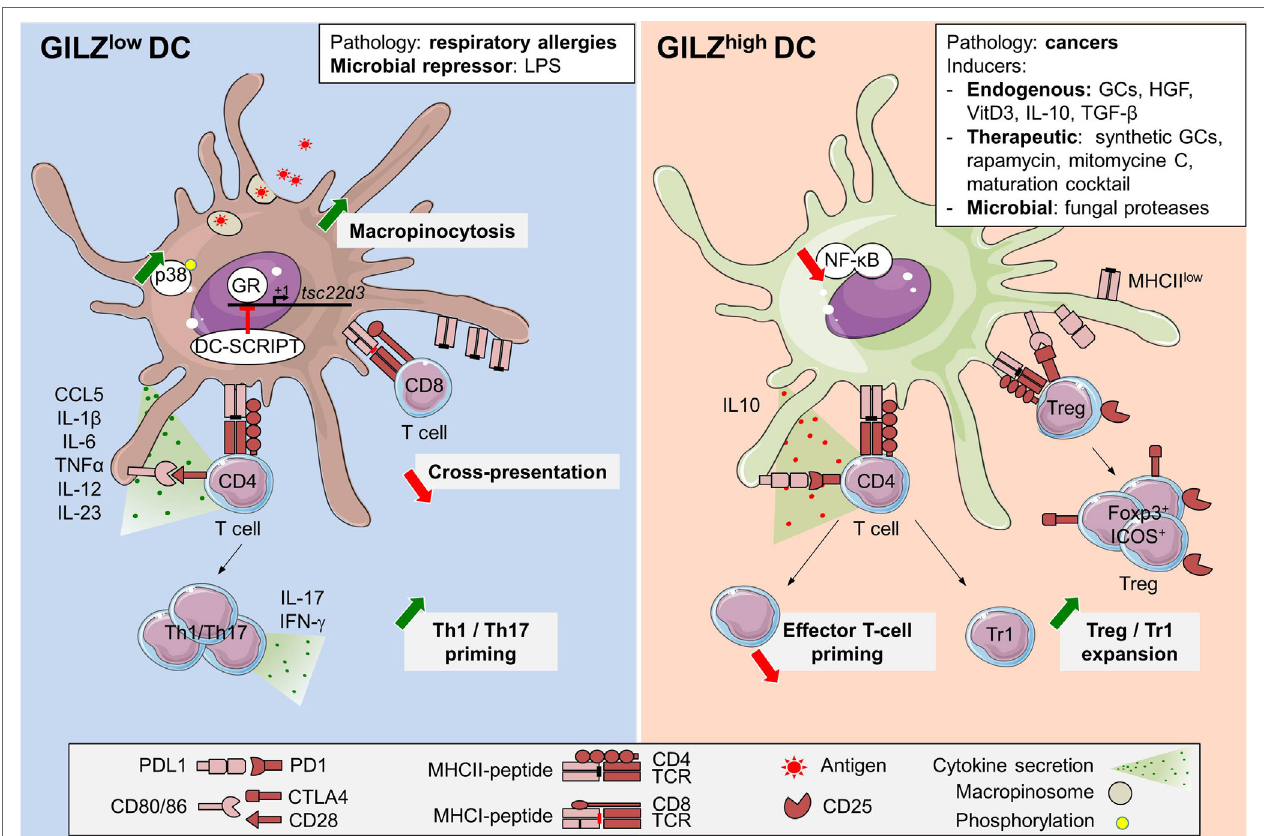
FiGURe 2 | Glucocorticoid-induced leucine zipper (GILZ) regulation and functions in dendritic cells (DCs). GILZ expression in DCs can be induced by steady-state factors (11, 21, 22), immunosuppressive cytokines like TGF- β or interleukin (IL)-10 (20, 25), DC-maturation cocktail containing TNF- α , IL-1 β , IL-6, and PGE2 (24), cell-derived factors (26, 45, 67), immunosuppressive drugs as synthetic GCs, rapamycin, and mitomycine C (11), fungal proteases (68), and cancer microenvironment (26). So far, the only exogenous GILZ repressor reported in DCs is LPS (26, 27). In addition, GILZ levels are reduced in blood DCs from respiratory allergic patients (21). DC-SCRIPT acts as an endogenous GR-repressor, thus limiting GILZ induction upon GCs exposure (64, 65). High GILZ levels promote PD-L1 expression and IL-10 production while limiting IL-12 and IL-23 secretion. Thus, GILZ hi DCs are poor inducers of Th1 and Th17 T cells but efficient Treg and Tr1 activators (20, 23, 25). GILZ inhibits NF- κ B functions upon interaction with p65 subunit (39, 46, 52). GILZ repression promotes macropinocytosis, likely upon increased p38-MAPK phosphorylation (27). GILZ deletion reduces antigen cross-presentation (27). GCs, glucocorticoids; TGF- β , transforming growth factor- β ; IL-10, interleukin-10; HGF, hepatocyte growth factor; LPS, lipopolysaccharide; ICOS, inducible co-stimulator; Foxp3, Forkhead box p3; NF- κ B, nuclear factor kappa B; CTLA4, cytotoxic T-lymphocyte-associated protein; Tr1, Type 1 regulatory T cells; Treg, regulatory T cells; p38-MAPK, p38 mitogen-activated protein kinase; GR, glucocorticoid receptor; cDC, conventional dendritic cell; tsc22d3, TGF- β -stimulated clone (TSC) 22 domain family protein 3